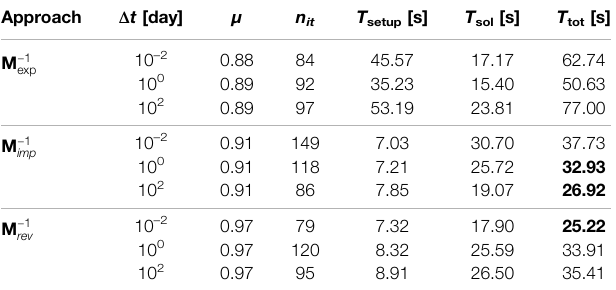
TABLE 3 | SPE10-16 test case: computational performance. Approach